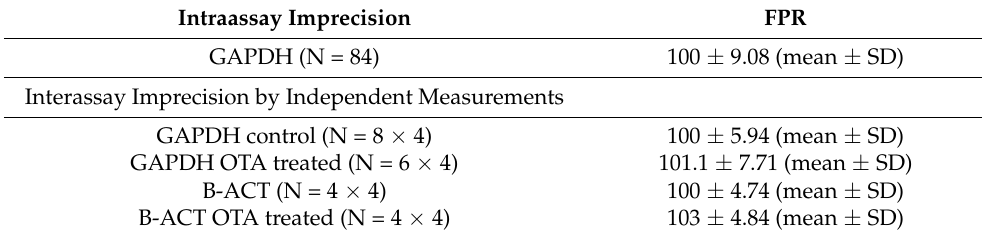
Table 2. Intraassay and interassay imprecision data of the multiplexed protein expression assay. For the intraassay study, GAPDH test was performed (N = 84); for interassay analysis, multiparametric test (2 different proteins) was performed (4–8 independent experiments with 4 technical replicates). Data are given as fluorescence/protein arbitrary units (FPR %) and in case of 10 µ M OTA treatment as % of the